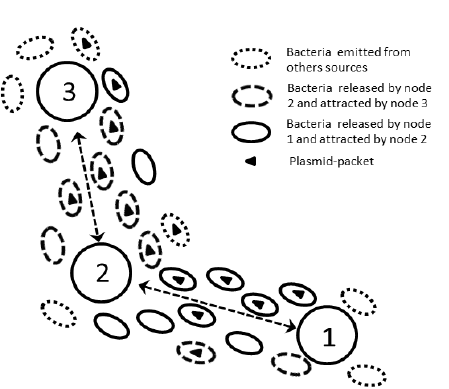
Figure 2: Opportunistic routing through conjuga-